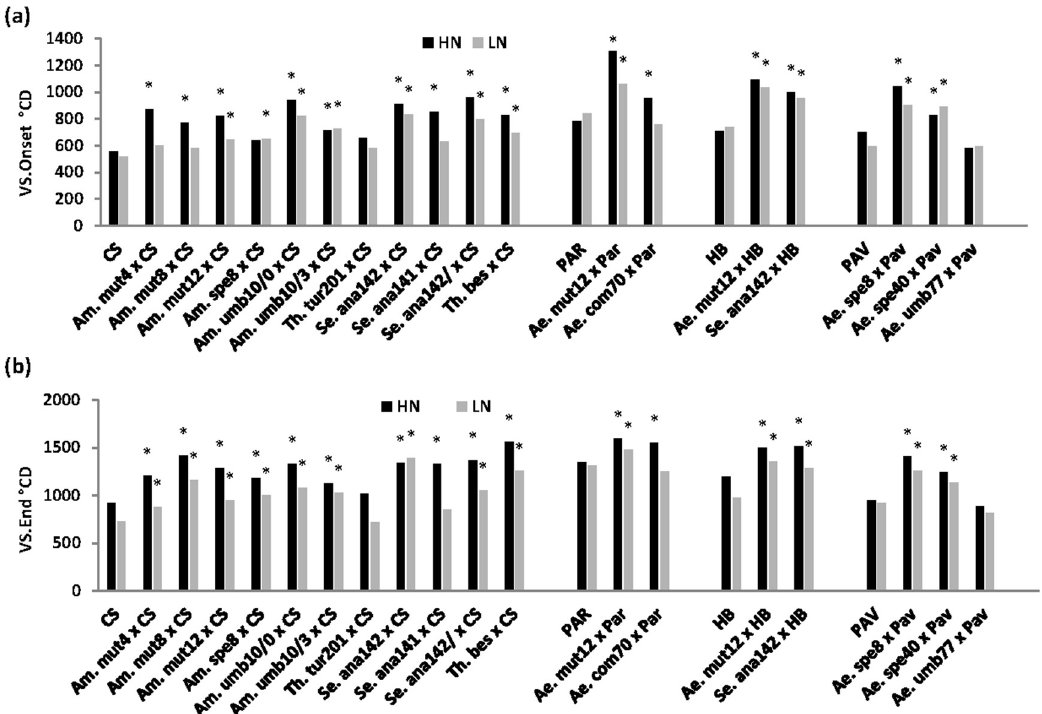
Fig 4. (a) Onset (VS.Onset) and (b) end (VS.End) of flag leaf sensencence (˚Cd post-anthesis (GS61), base temp. 0˚C) for 22 genotypes (18 amphidiploid lines and 4 parents) under HN and LN conditions (mean 2015 and 2016). ( � indicates transgressive segregation above respective bread wheat parent at 5% level of